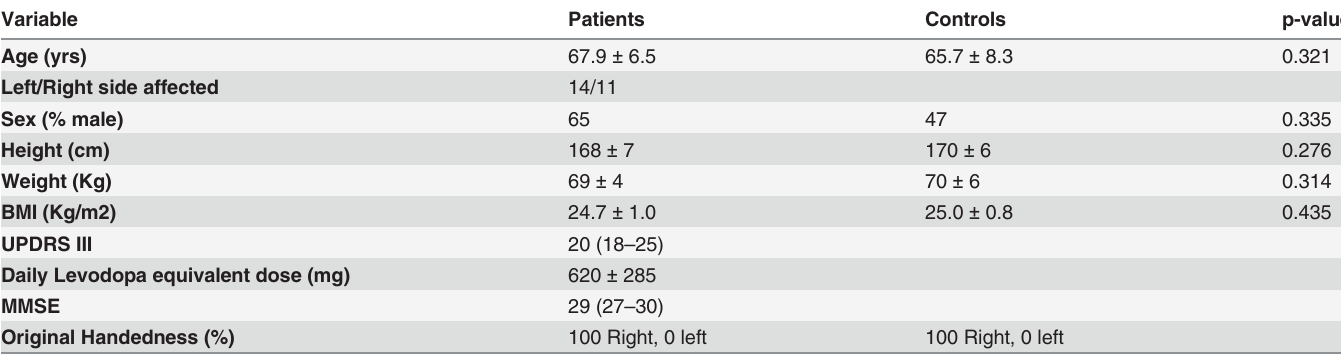
Table 1. Demographic and clinical data of patients and controls.